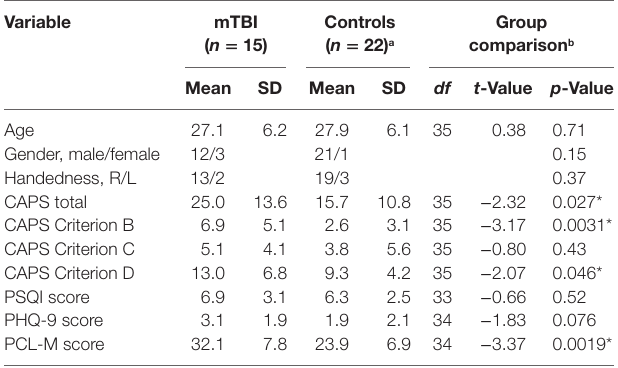
TaBle 1 | Participant characteristics and psychological